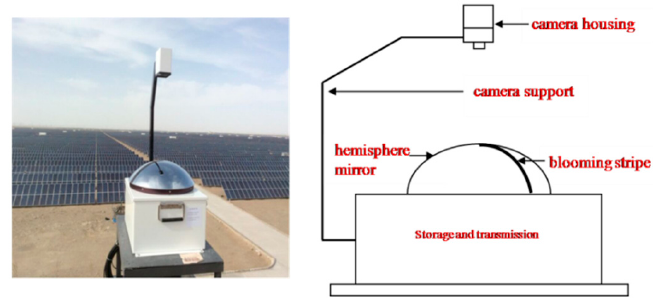
Figure 1. Appearance and composition of total sky imager (TSI-880).